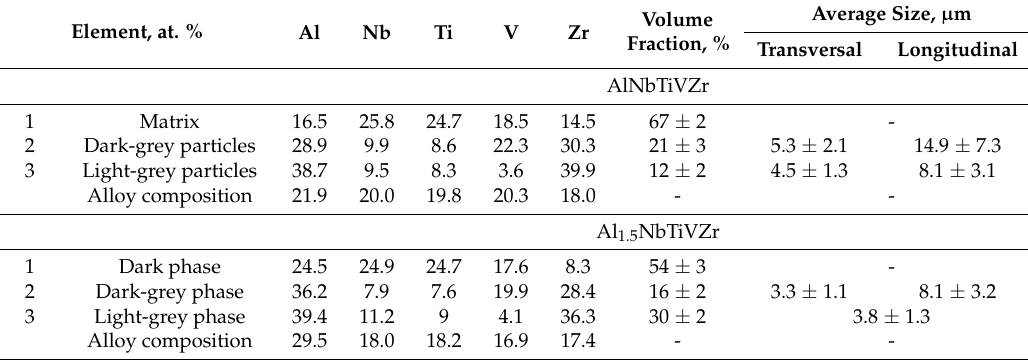
Some individual Laves particles are also found in the matrix phase. The matrix, grey hcp and black Laves phases have volume fractions of 46%, 35% and 19%,